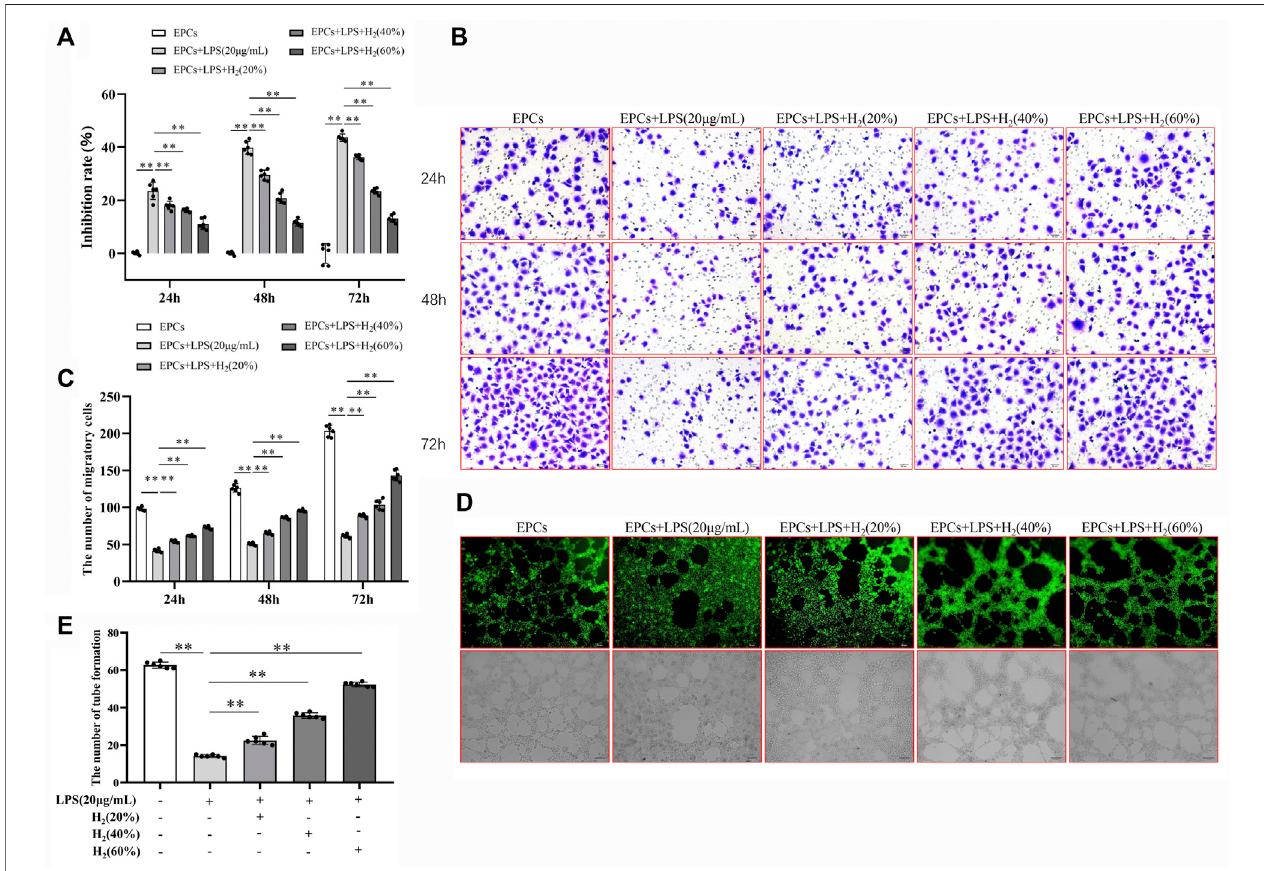
FIGURE 3 | H 2 alleviated EPCs dysfunctions induced by LPS. EPCs treated with LPS induced EPCs damage, and then EPCs were treated with different concentrations (20%, 40%, 60%) for different time (24, 48, 72 h). The viability of EPCs was assessed by MTT assay (A) . EPCs migration was measured by transwell assay (B,C) . Tube formation was measured by a Tube formation assay (D,E) . Data are presented as mean ± SD ( n = 6); ** p < 0.01.